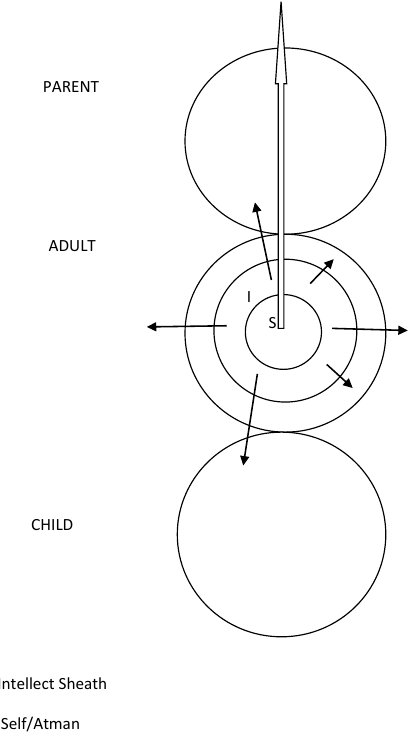
Figure 2. The Vedantic Model of Ego